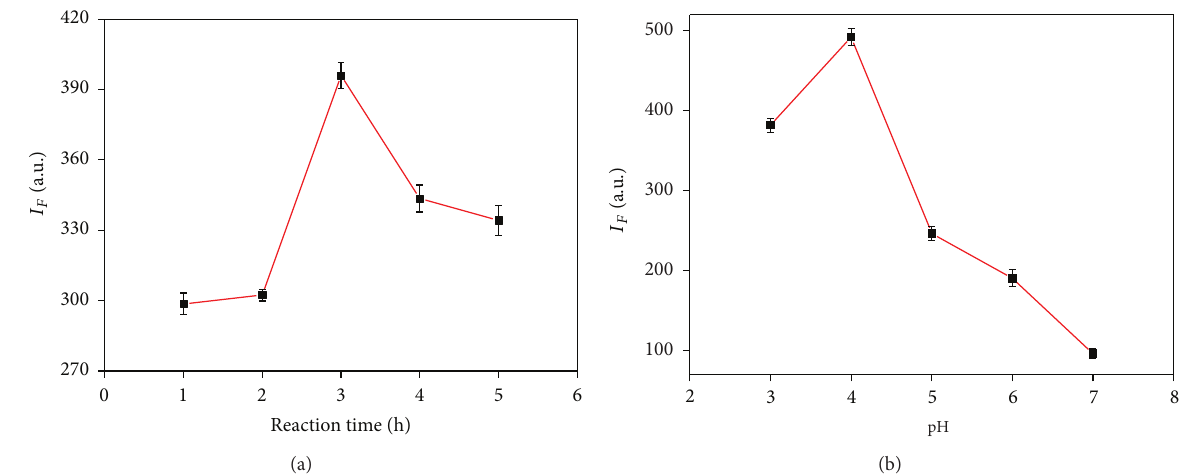
Figure 4: The effect of (a) reaction time and (b) pH value on the fluorescence intensity of Ag